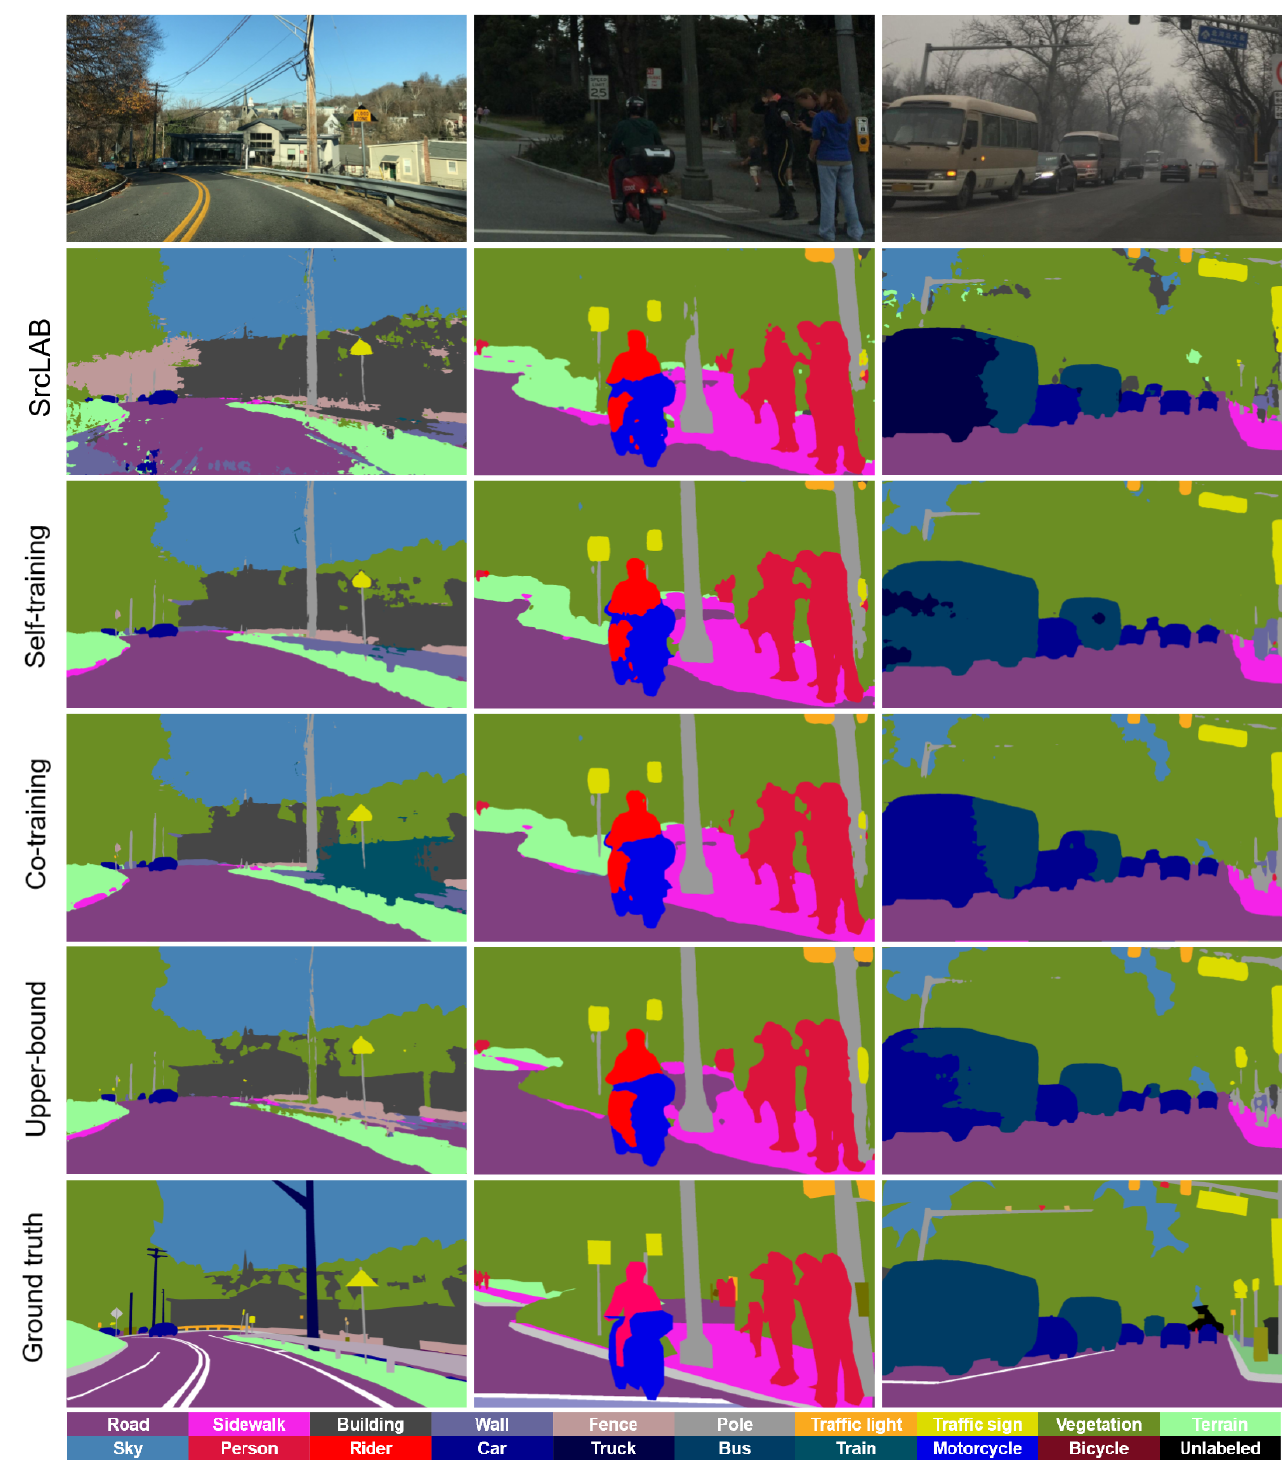
Figure A10. Analogous to Figure A9, focusing on problematic